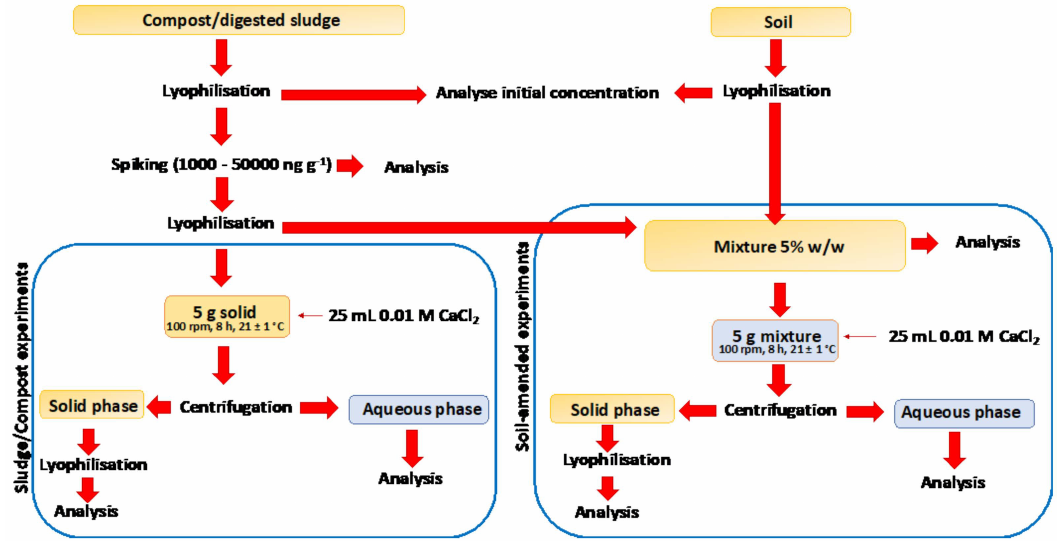
Figure 5. Schematic representation of the batch